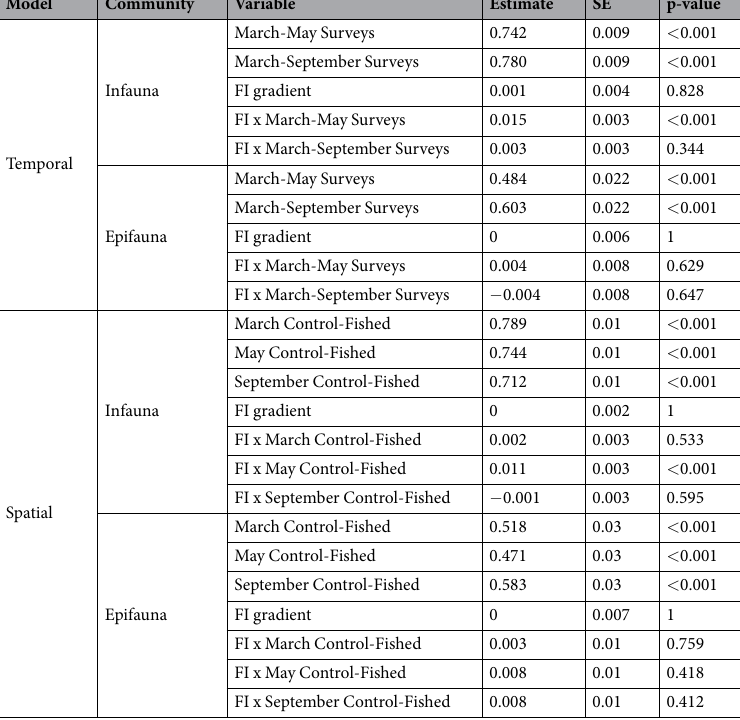
Table 5. Effect of fishing intensity (FI) on Bray Curtis community dissimilarity estimates, assessed with linear mixed effect models. The temporal models compared the within-site differences between surveys, i.e. seasonal turnover, while the spatial models compared the within-survey differences between control and fished sites, i.e. spatial turnover. Given are model estimates of BC indices, standard errors (SE) and